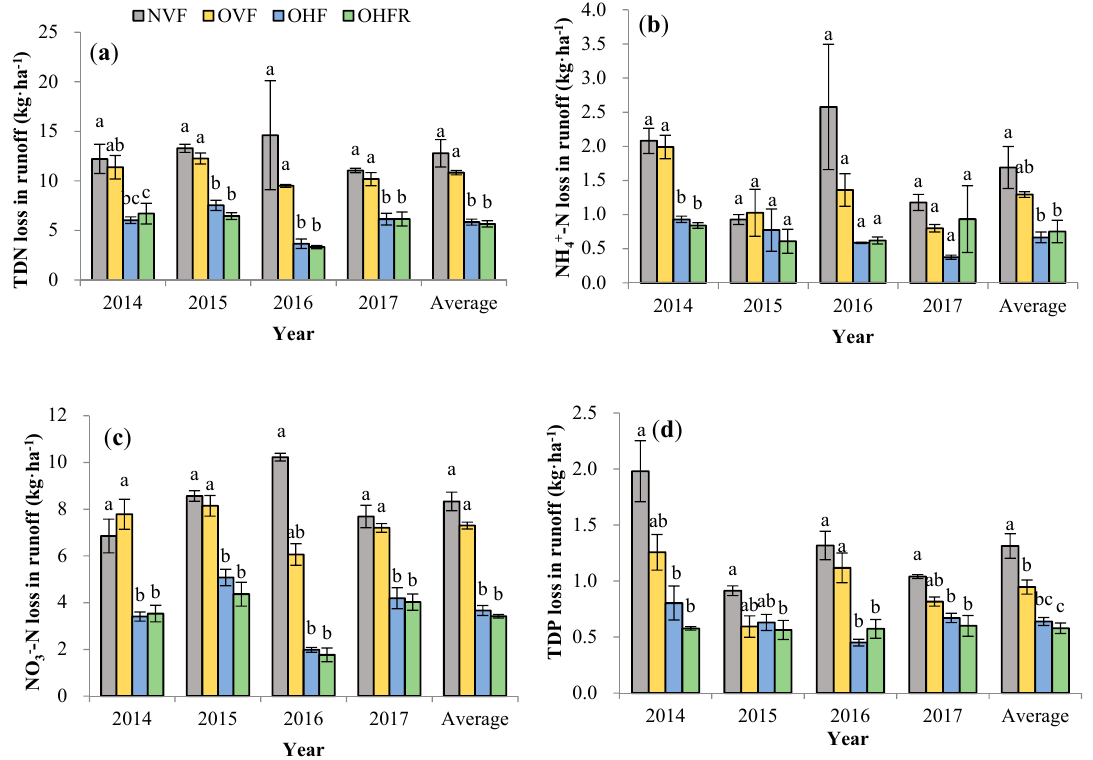
Figure 4. Di ff erent forms of nitrogen (TDN (a), NH 4 + -N (b), and NO 3 − -N (c)) and phosphorus (TDP) Figure 4. Different forms of nitrogen (TDN (a), NH 4+ -N (b), and NO 3- -N (c)) and phosphorus (TDP) loss (d) in runo ff from trial plots during 2014–2017. Error bars represent ± standard loss (d) in runoff from trial plots during 2014–2017. Error bars represent ± standard errors.